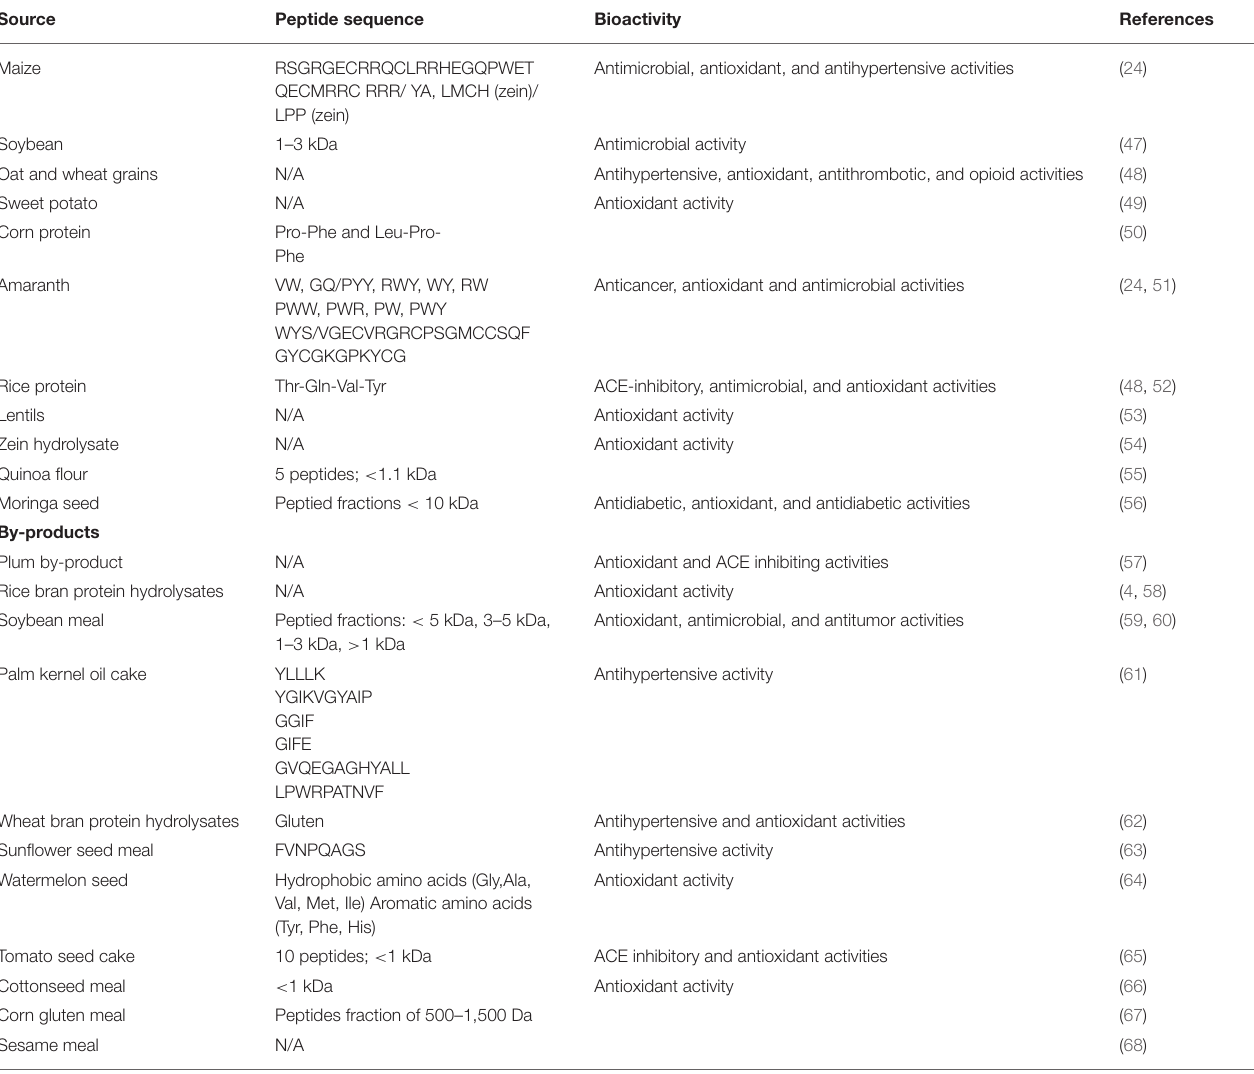
TABLE 3 | Peptides from plants and by-products and their